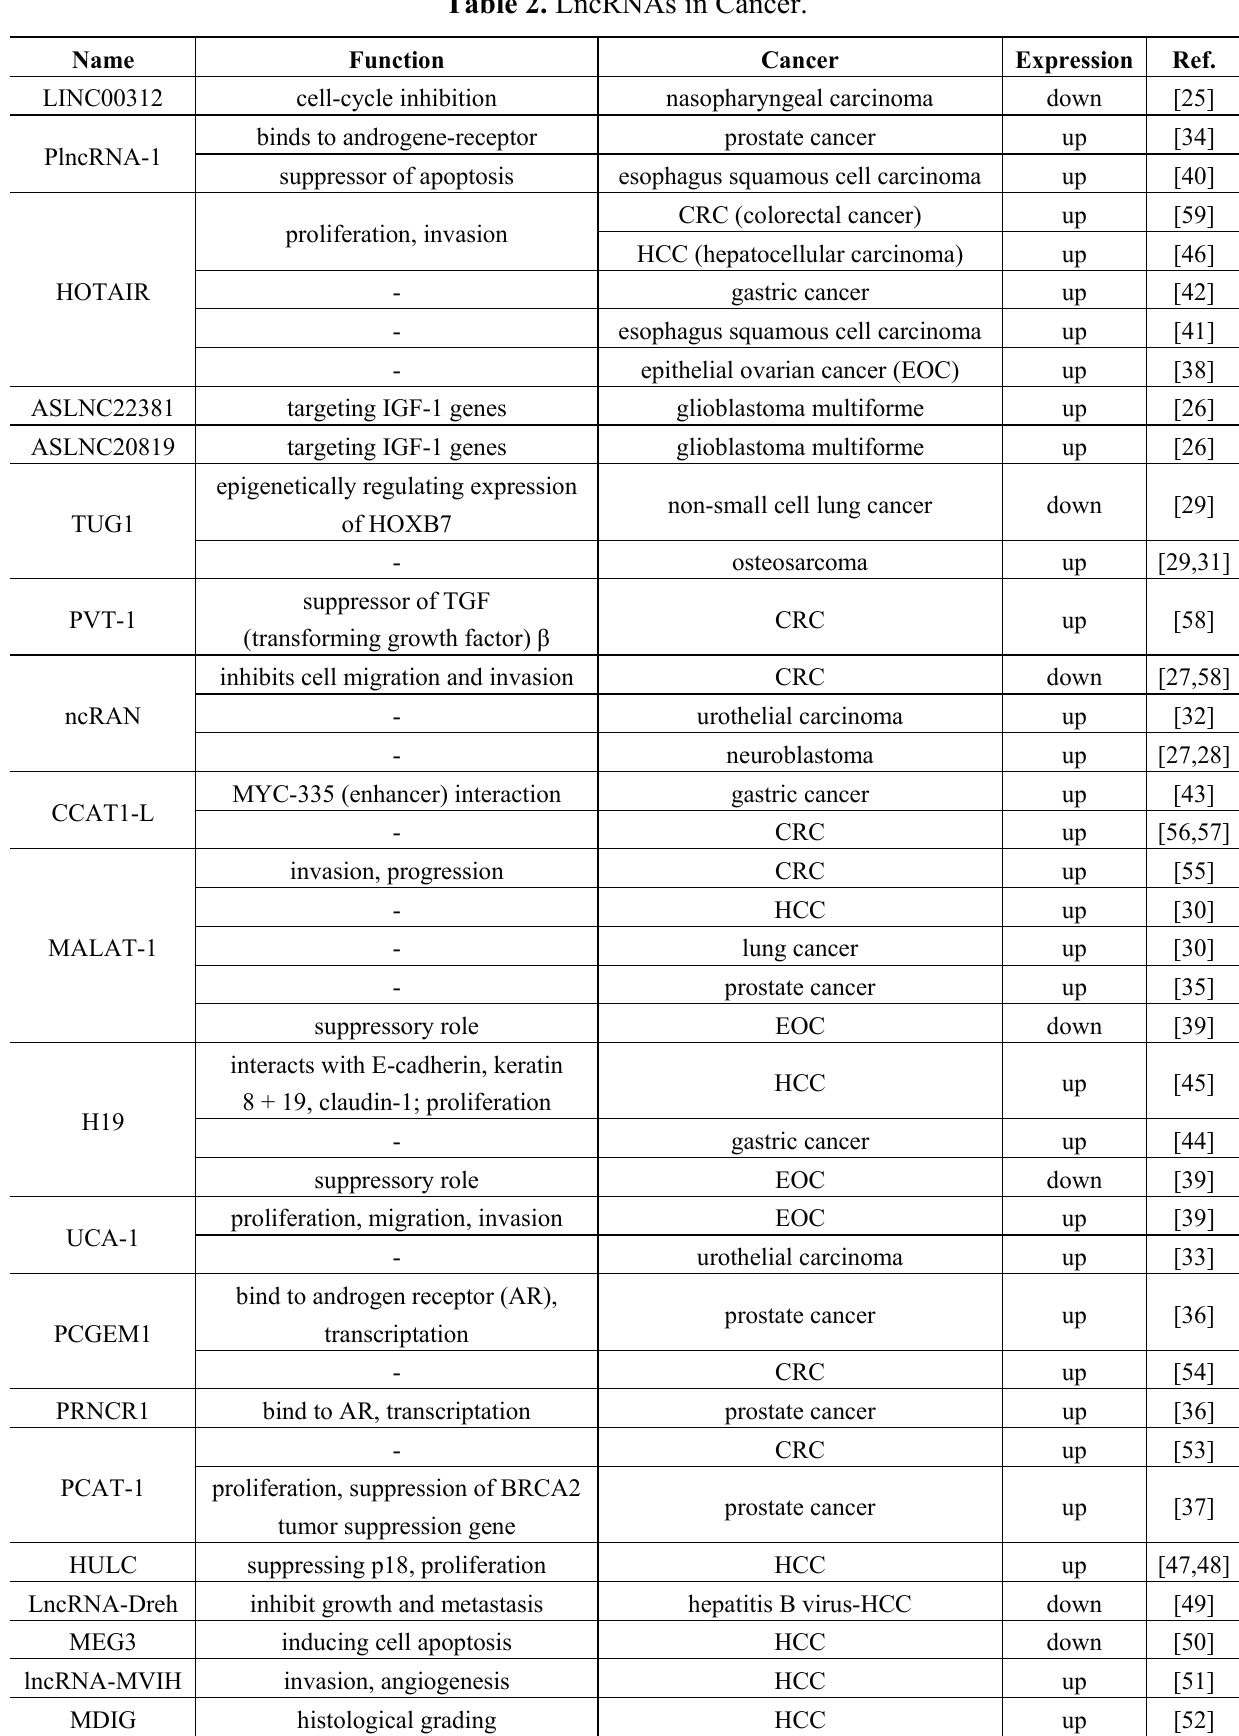
Table 2. LncRNAs in